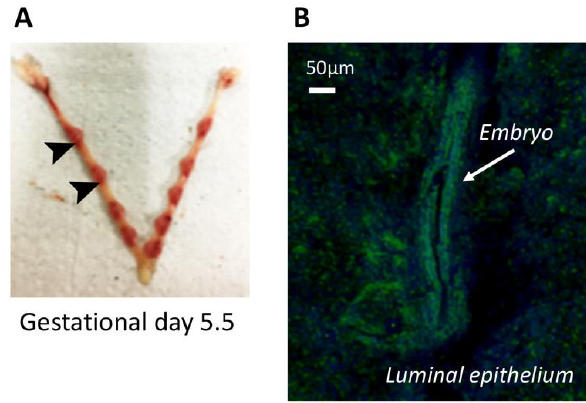
Figure 7. AnxA1 is expressed at embryo-implantation site in vivo. Implantations sites were obtained from C57bl/6 at gestational day 5.5 ( A ). Representative image of AnxA1 expression at implantation site (arrow) and luminal tissue by confocal microscopy is shown ( B ).